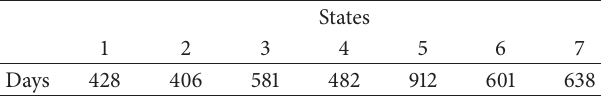
Table 5: Number of days for each state, from which the composites maps are